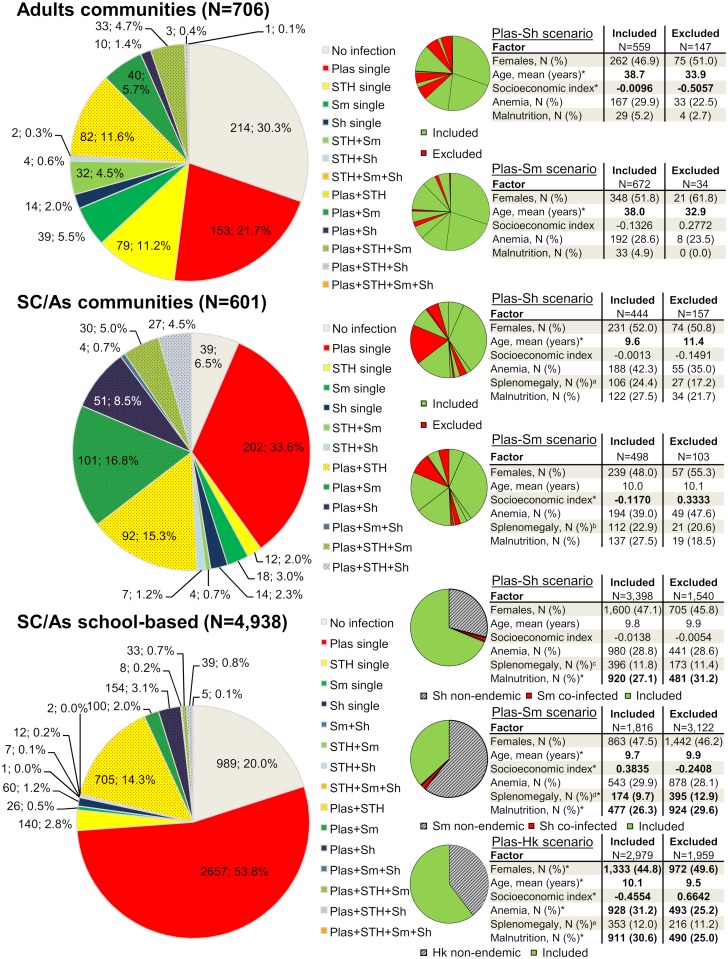
Multiple species infection profiles in adults, school-aged children/adolescents (SC/As) from communities and SC/As from the national school-based survey, subsamples drawn for each Plasmodium-helminth scenario and potential differences between included and excluded individuals for interaction analysis.Parasite species abbreviations: Plasmodium (Plas), S. mansoni (Sm), S. haematobium (Sh), soil-transmitted helminth (STH) and hookworm (Hk). *Statistically significant with a p-value<0.05 according to Χ2-test or t-test as appropriate. aBased on a total of 592 whereof 435 were included and 157 excluded. bBased on a total of 592 whereof 490 were included and 102 excluded. cBased on a total of 4,870 whereof 3,347 were included and 1,523 excluded. dBased on a total of 4,870 whereof 1,801 were included and 3,069 excluded. eBased on a total of 4,870 whereof 2,933 were included and 1,937 excluded.